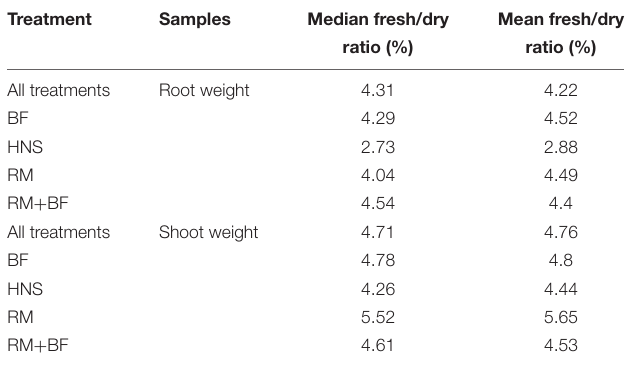
TABLE 3 | Ratio between fresh and dry weights for shoots and roots at harvest. TABLE 4 | Phosphorus as percentage weight over the average dry weight for each